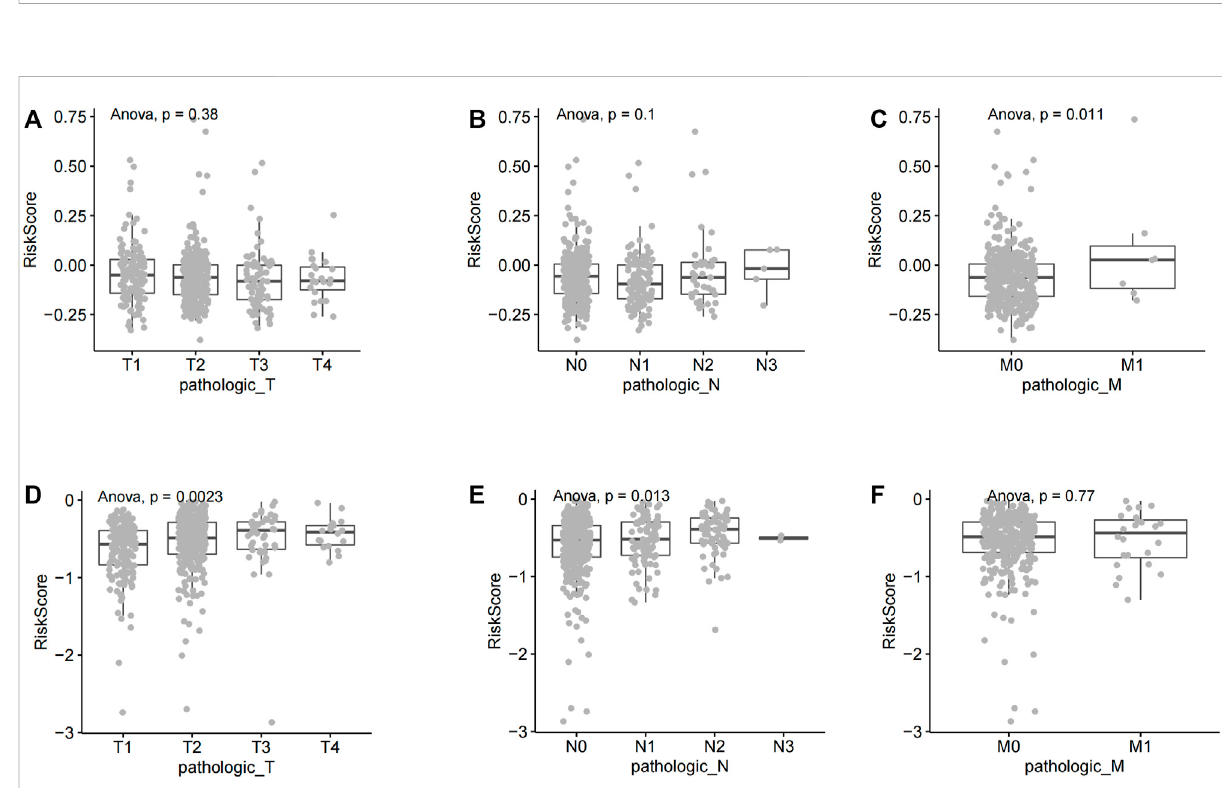
risk score has signi fi cant statistical difference in different T stages (T1, T2, T3, and T4 stages) of lung adenocarcinoma ( p = 0.0023, < 0.01) (Figure 5D). Similarly, the risk score has signi fi cant statistical difference in different N stages (N0, N1, N2, and N3 stages) of lung adenocarcinoma ( p = 0.013, < 0.05) (Figure 5E). The risk score lack of signi fi cance in different M stages of lung adenocarcinoma (Figure 5F).